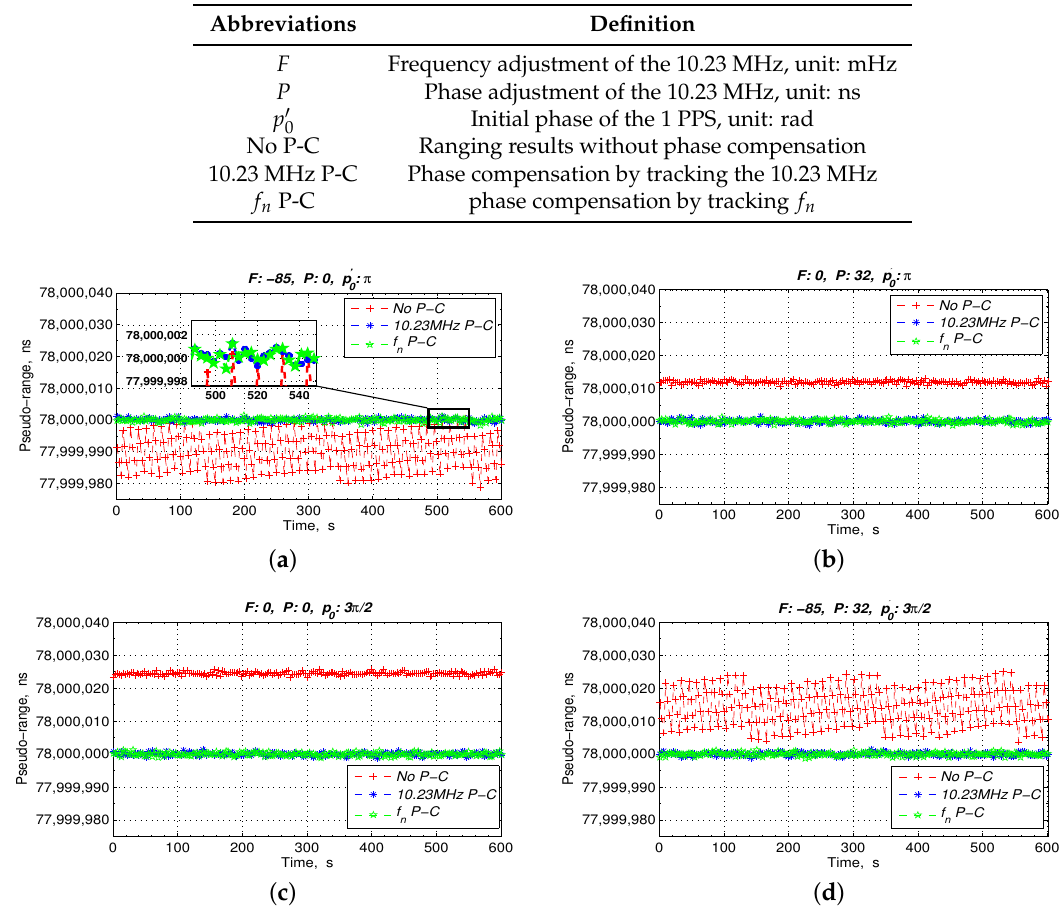
Figure 8. Ranging results with the 1 PPS in the non-skip-area. ( a ) only frequency adjustment; ( b ) only phase adjustment; ( c ) only change p (cid:48)